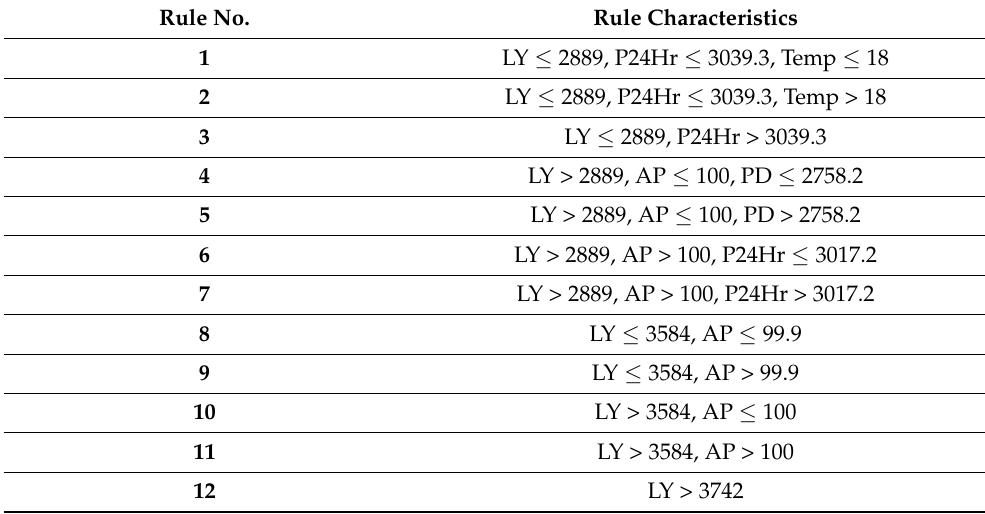
Table 4. Rule Characteristics. Rule